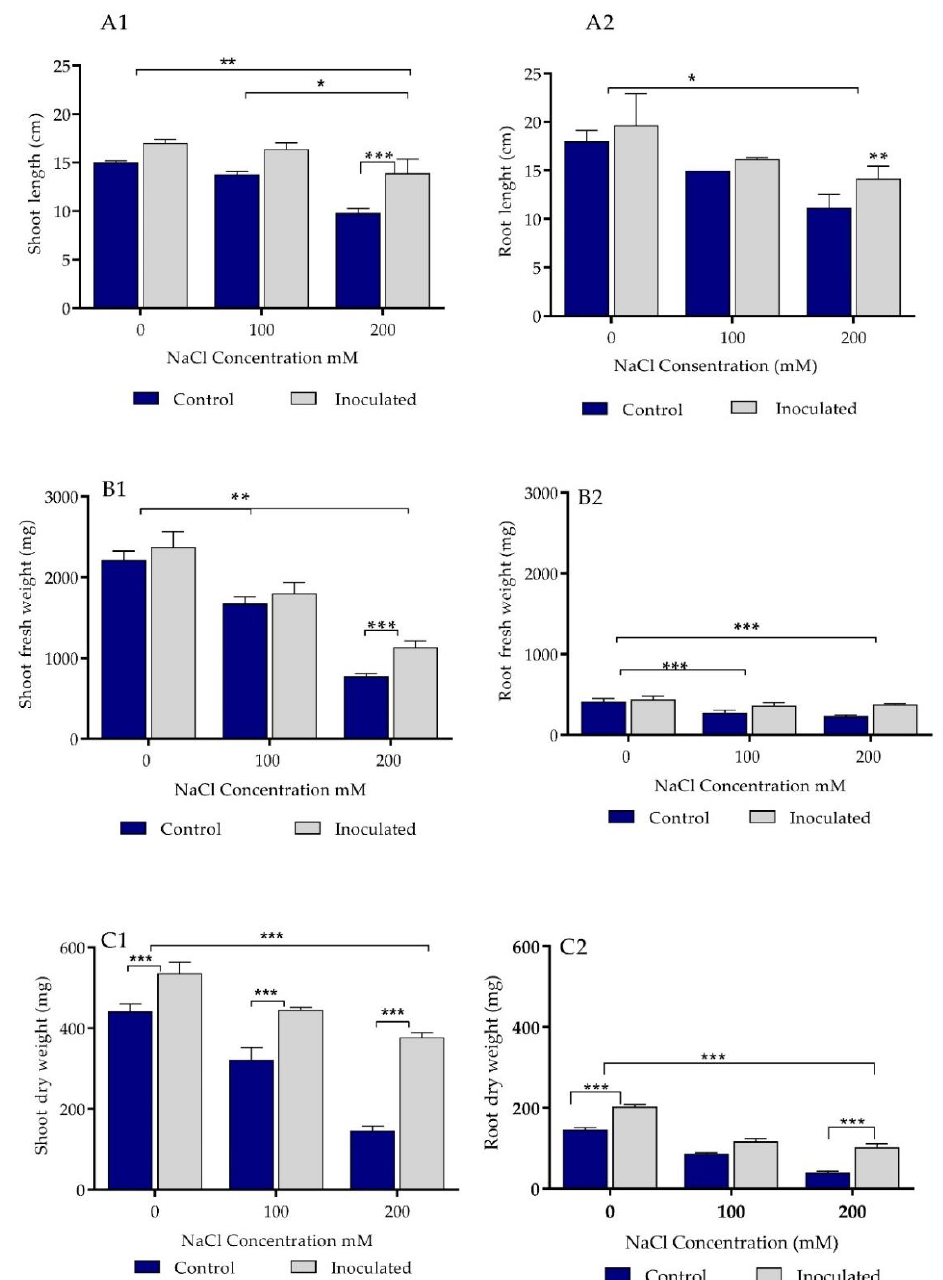
Figure 3. E ff ect of P. agglomerans strain Pa inoculation on growth parameters of durum wheat cv Waha grown in sand pots under saline and non-saline conditions. ( A1 , A2 ) E ff ect of bacterial inoculation (strain Pa) on shoot and root length (cm) in the presence of three concentrations (0, 100, and 200 mM) of NaCl. ( B1 , B2 ) E ff ect of bacterial inoculation (isolate Pa) on shoot and root fresh weight (mg) of Triticum durum L. cv Waha in the presence of three concentrations (0, 100, and 200 mM) of NaCl. ( C1 , C2 ) E ff ect of bacterial inoculation (strain Pa) on shoot and root dry weight (mg) of Triticum durum L. cv Waha in the presence of 0, 100, and 200 mM concentrations of NaCl. The bar plots represent the mean ± standard error of three di ff erent experiments. GraphPad Prism 8 was used to perform statistical analysis, using a two-way ANOVA and Tukey’s multiple comparison post-test. Only significant di ff erences are displayed: * p < 0.05, ** p < 0.01, *** p <